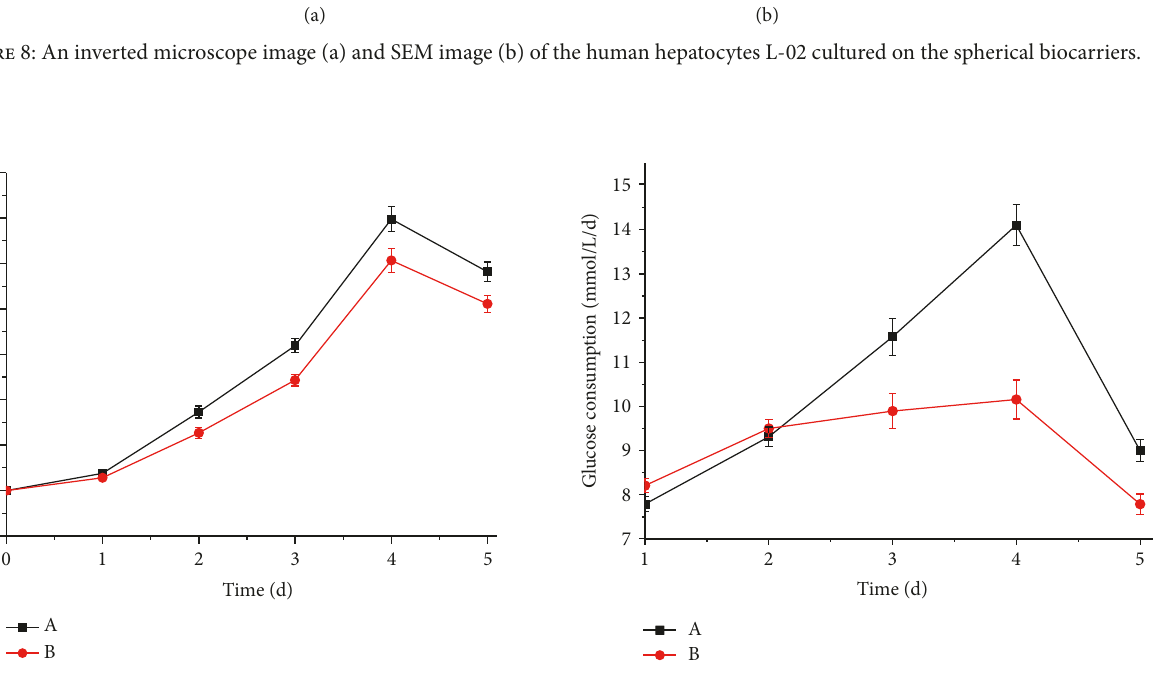
Figure 11: Glucose consumption of human hepatocytes cultured on biocarriers (A) and conventional media